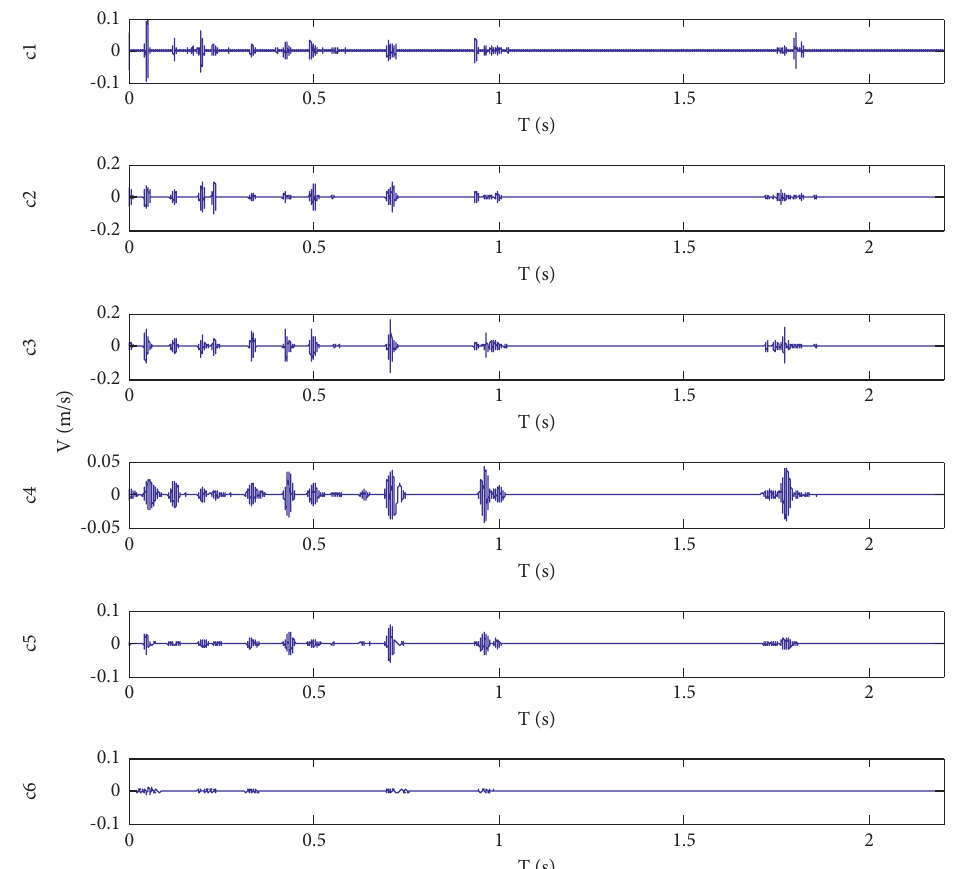
Figure 6: IMF1 ∼ IMF6 components using EMD